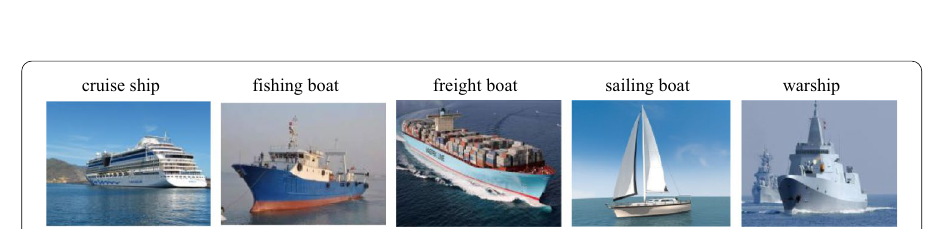
Fig. 6 Sample image of the